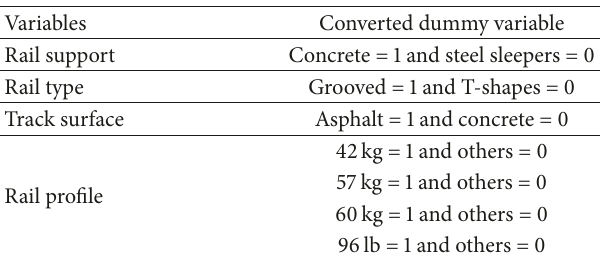
Table 1: List of dummy